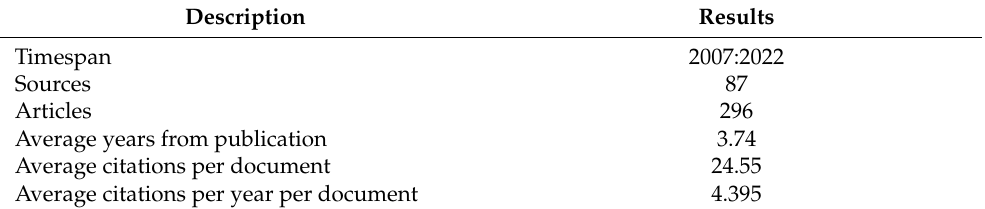
Table A5. Main information from sample 2. Source: own study using data from Bibliometrix.